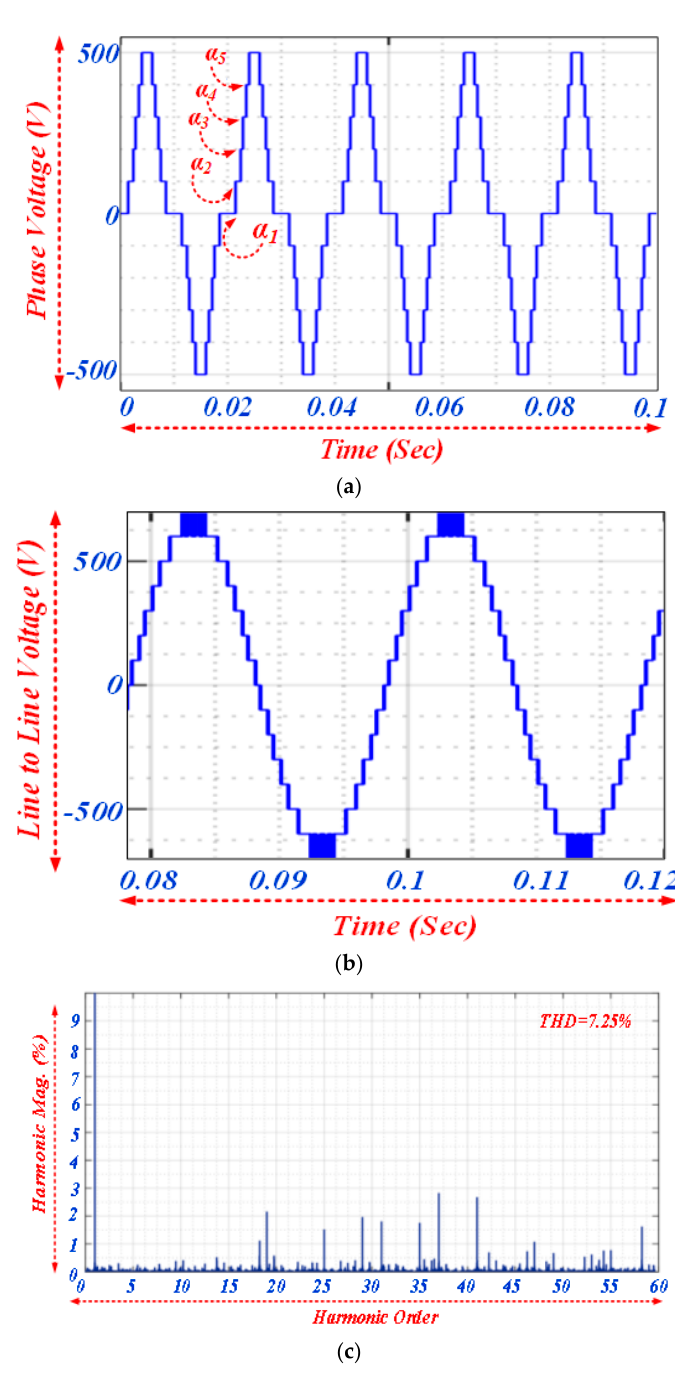
Figure 9. Simulation result for pattern ‘ a ’ at M = 0.6000 ( a ) Phase voltage; ( b ) line voltage; ( c ) harmonics spectrum.